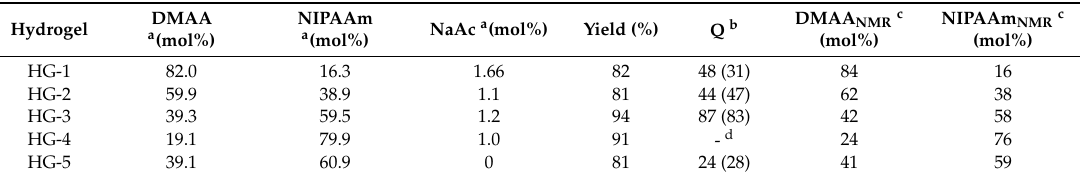
Table 1. Synthesis of hydrogels based on N,N-dimethylacrylamide, N-isopropylacrylamide and sodium acrylate a (HG-1–HG-5), Q values and experimental composition.